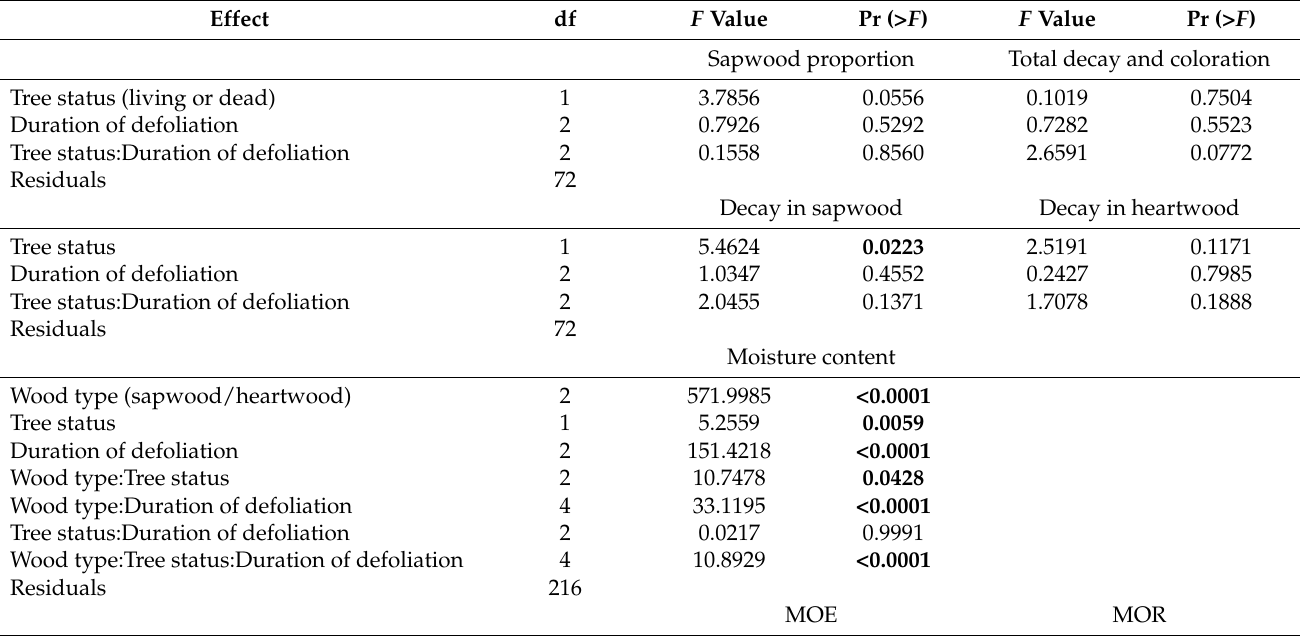
Figure 1. Proportion of sapwood ( A ) and decay and coloration in sapwood ( B ) for trees visually classified as living and dead from stands that have been defoliated for three, four or five years. Table 2. Mixed model ANOVA results for all the wood quality parameters evaluated in balsam fir. Significant results are highlighted in bold.